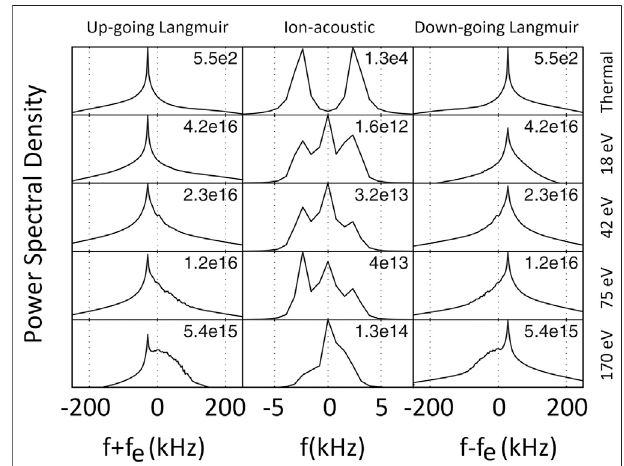
FIGURE 7 | Adapted from Isham et al. (2012): Results from a one- dimensional simulation with plasma parameters of the auroral F region. The spectra of up and down-going Langmuir and ion-acoustic waves are calculated for a wavelength of about 0.67 m ( k ≈ 9 . 4 m − 1 ), approximately matching the Bragg backscatter condition of the European Incoherent Scatter Scienti fi c Association (EISCAT) 224-MHz radar located nearTromsø,Norway.Modi fi cationofthespectraduetoLangmuirturbulence produced by downward-going beams of electrons at beam energies of 18, 42, 75,and 170 eV areshown. Theappearanceofthezero-frequency peak in the ion-acoustic channel and the broadened spectral peaks associated with Langmuir waves are signatures of caviton formation and wave collapse. Δ v / v (cid:1) 0 . 3 and n / n (cid:1) 2 × 10 − 5 are adopted for the beams. The b b b 0 parameters result in P ≈ 0 . 09, corresponding to the kinetic regime of beam- plasma instability. The numbers at the top right section of each panel indicate the peak value of each